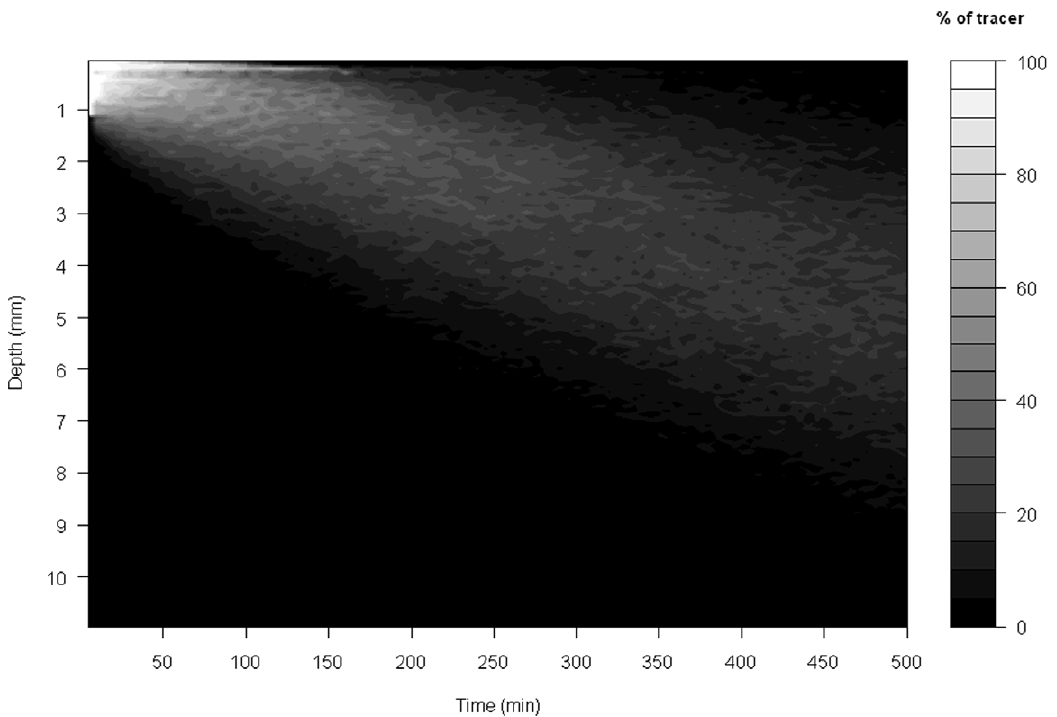
Figure 2. Visualisation of the results of the simulation model where grey shades denote the relative density of luminophores at a given depth (y-axis) and time point (x-axis).